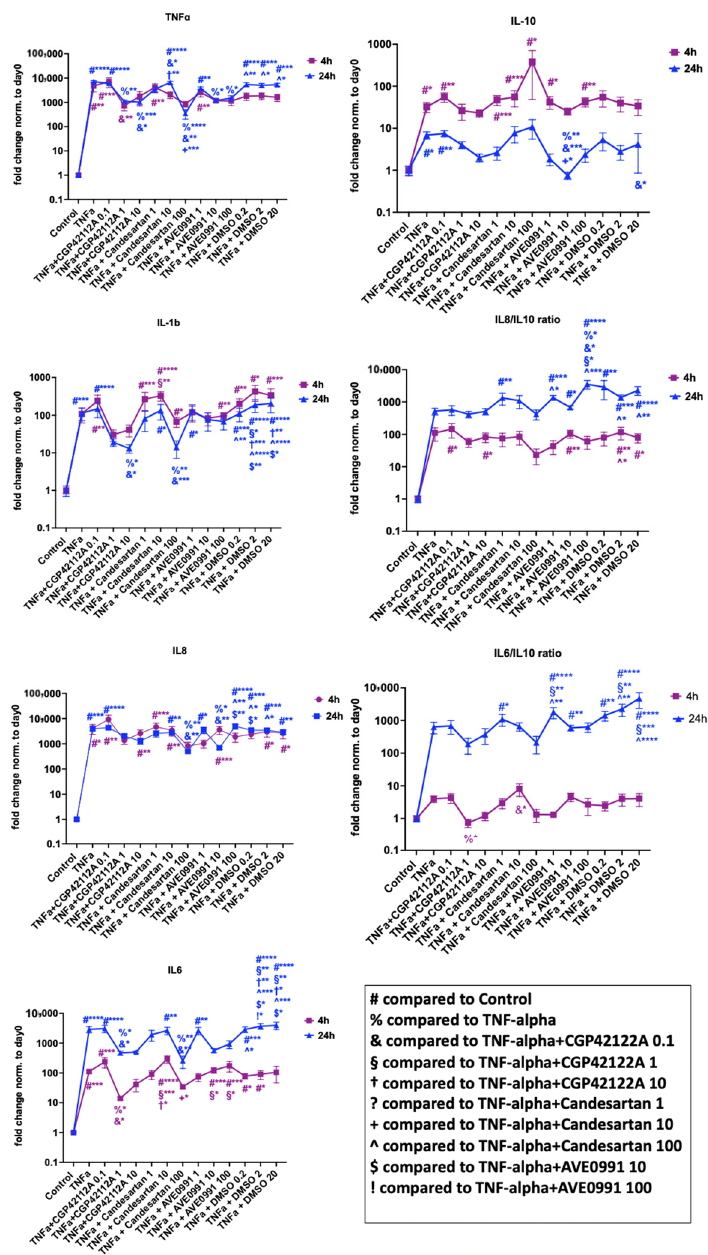
Figure 6. Gene expression analysis of inflammation-related markers in human NP cells for candesartan (1 µ M, 10 µ M, 100 µ M), the MAS-receptor agonist AVE 0991 (1 µ M, 10 µ M, 100 µ M), and the AGTR2-receptor agonist CGP-42112A (0.1 µ M, 1 µ M, 10 µ M) with 4 h and 24 h of exposure in inflammatory settings (TNF- α addition). DMSO (0.1 µ L/mL, 1 µ L/mL, 10 µ L/mL; shown in µ L volume on the x -axis) was used as the solvent control. Fold change values normalized to the baseline (day 0) are shown. n = 4 biological replicates and n = 3 technical replicates per donor were assessed. Mean and standard error of the mean (SEM) are shown. * p < 0.05; ** p < 0.01; *** p < 0.001; **** p <